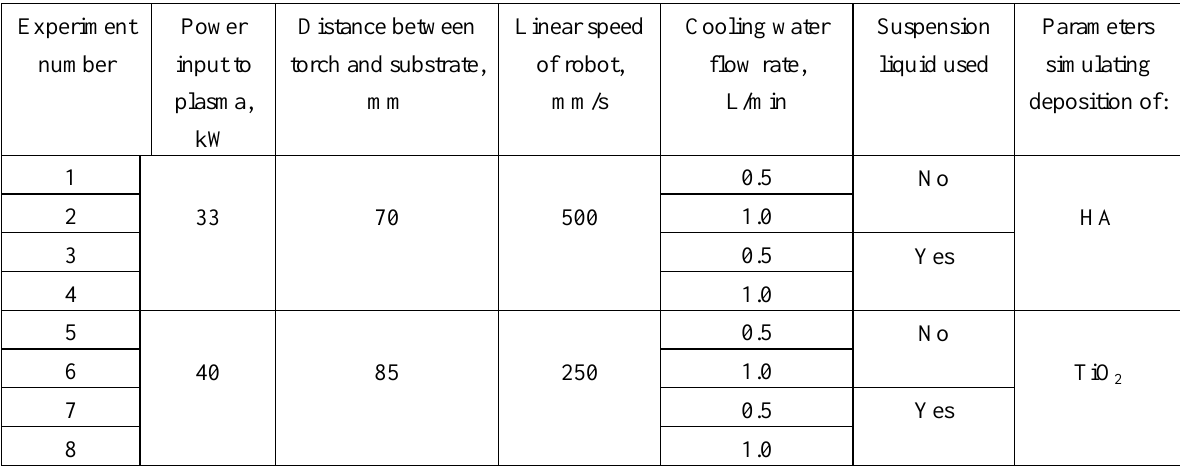
Table 1. Plan of experiments for determining the heat flux input to the substrate.